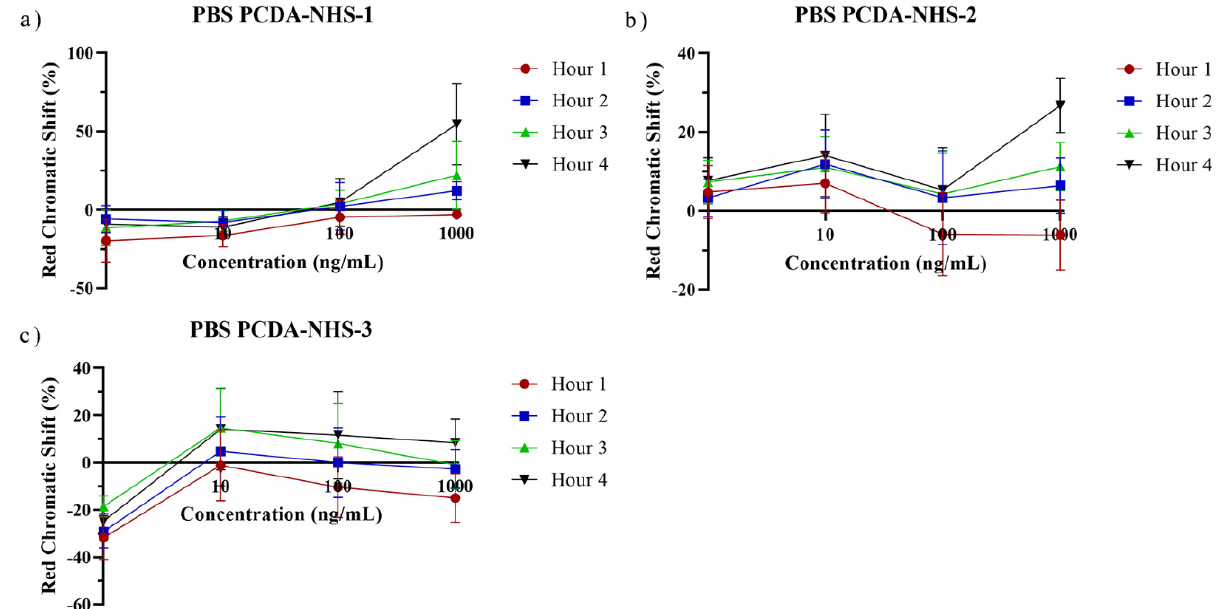
Figure 5. Hourly red chromatic shift for PBS samples. RCS data obtained from sensors of PCDA-NHS-1 ( a ), PCDA-NHS-2 ( b ), and PCDA-NHS-3 ( c ) groups exposed to 1, 10, 100, and 1000 ng/mL of SARS-CoV-2 spike protein in PBS buffer. As time increased, RCS tended to increase for sensors at each concentration.